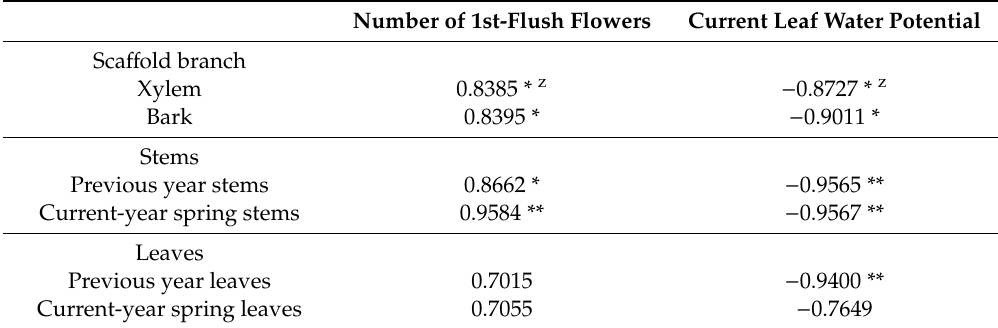
Table 4. Correlation coe ffi cients between sugar contents in each tree organ and the number of first-flush flowers or the current leaf water